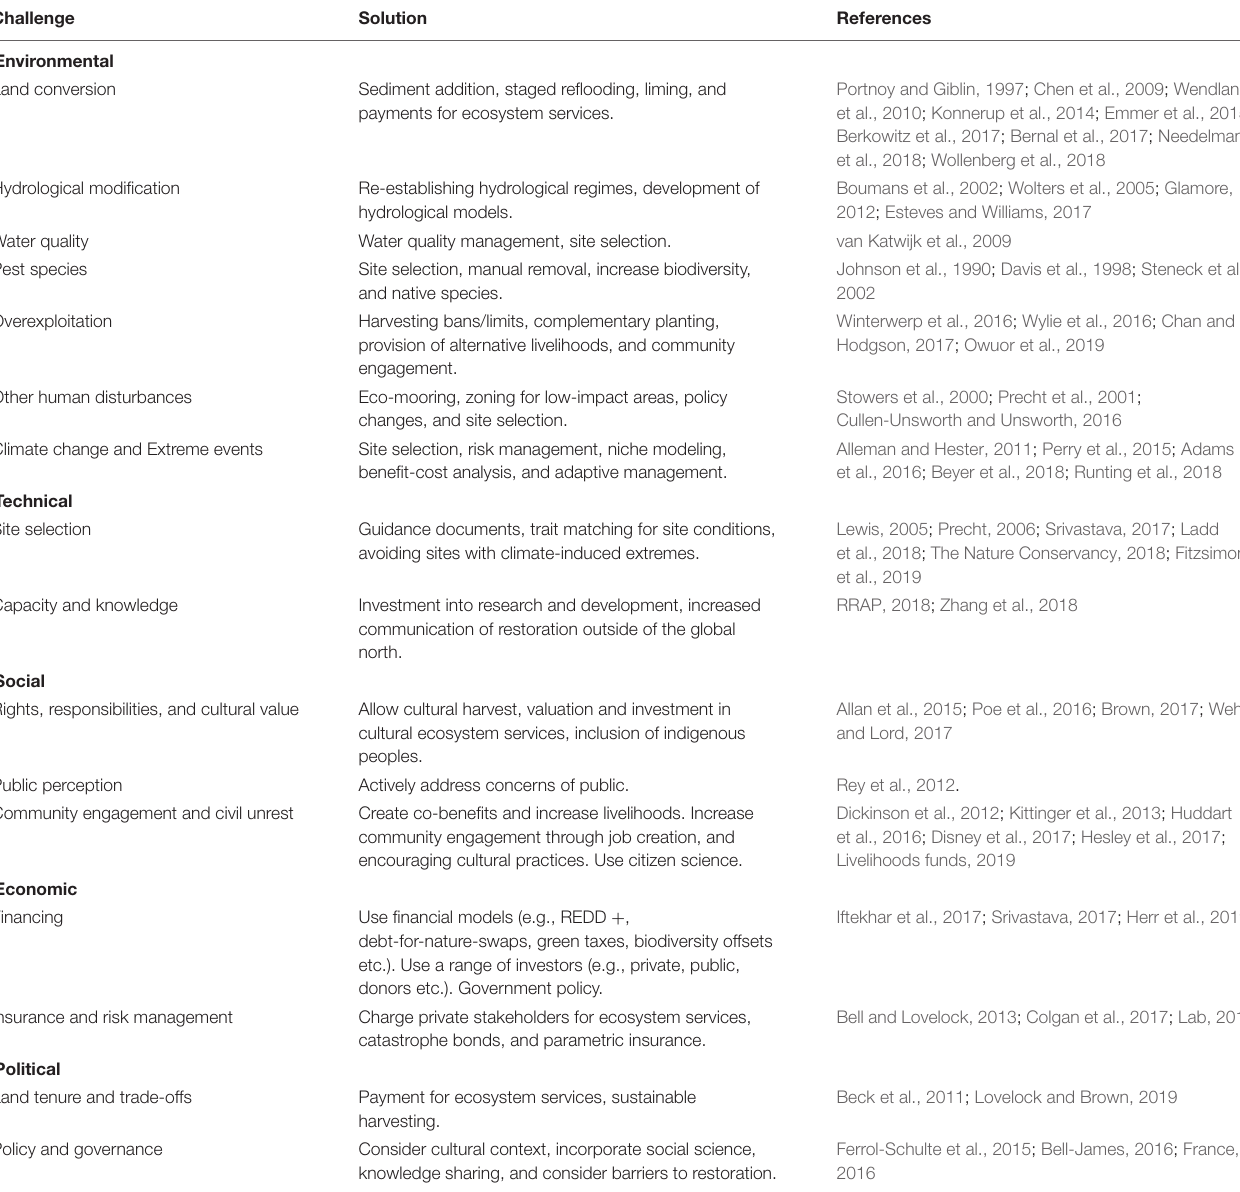
TABLE 1 | Examples of solutions to the common barriers to blue